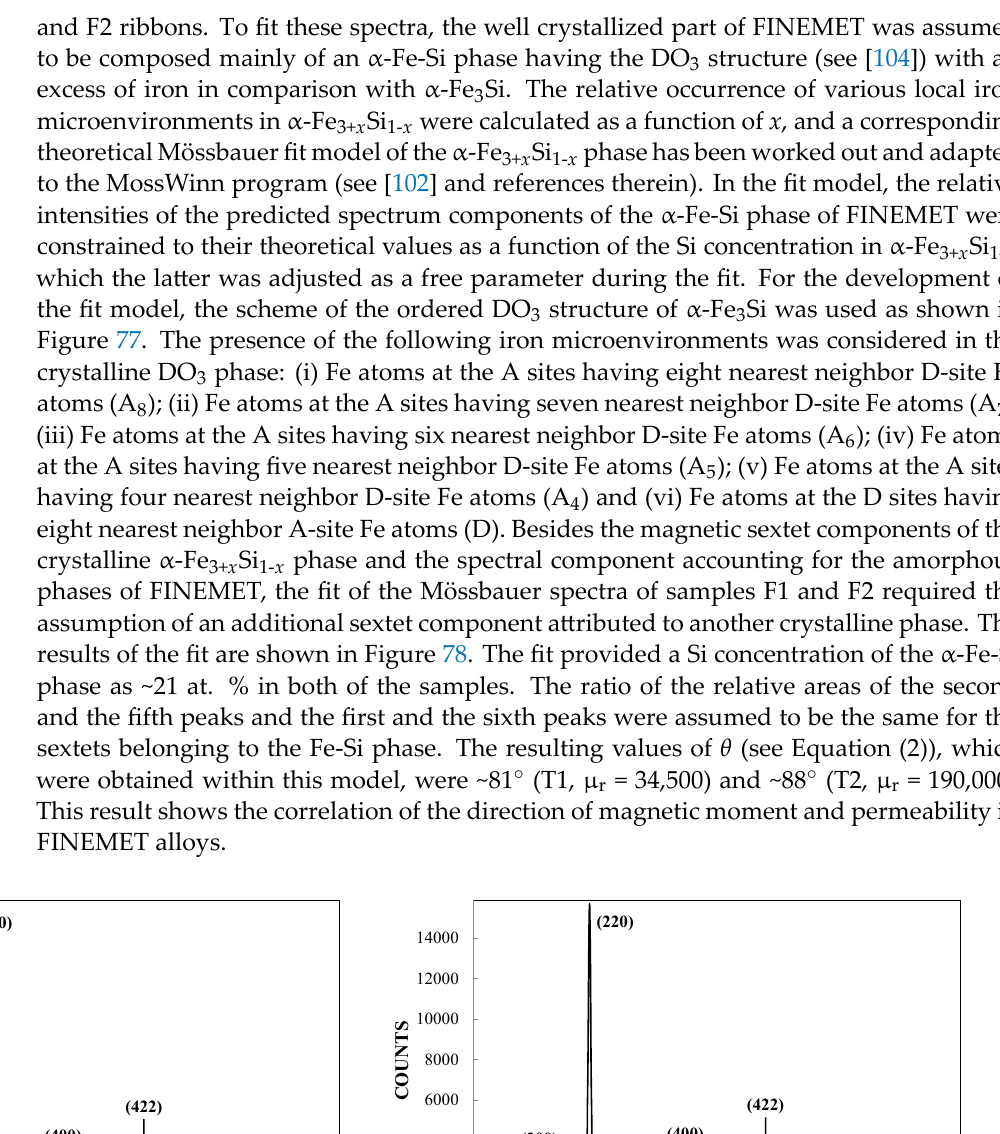
( c ) Figure 76. Room temperature Mössbauer spectra of FINEMET ribbons with different permeabili ‐ ties: F1, μ r = 34,500 ( a ) and F2, μ r = 190,000 ( b ) and their normalized differences ( c ). The Mössbauer spectra were measured in 4096 channels and converted into 2048 ‐ channel spectra. Adapted from Ref. [102] with permission from Elsevier: Materials Chemistry and Physics, Vol. 180, Oshtrakh M.I., Klencsar Z., Semionkin V.A., Kuzmann E., Homonnay Z., Varga L.K., “Annealed FINEMET rib ‐ bons: structure and magnetic anisotropy as revealed by the high velocity resolution Mössbauer spectroscopy”, 66–74, ©2016.